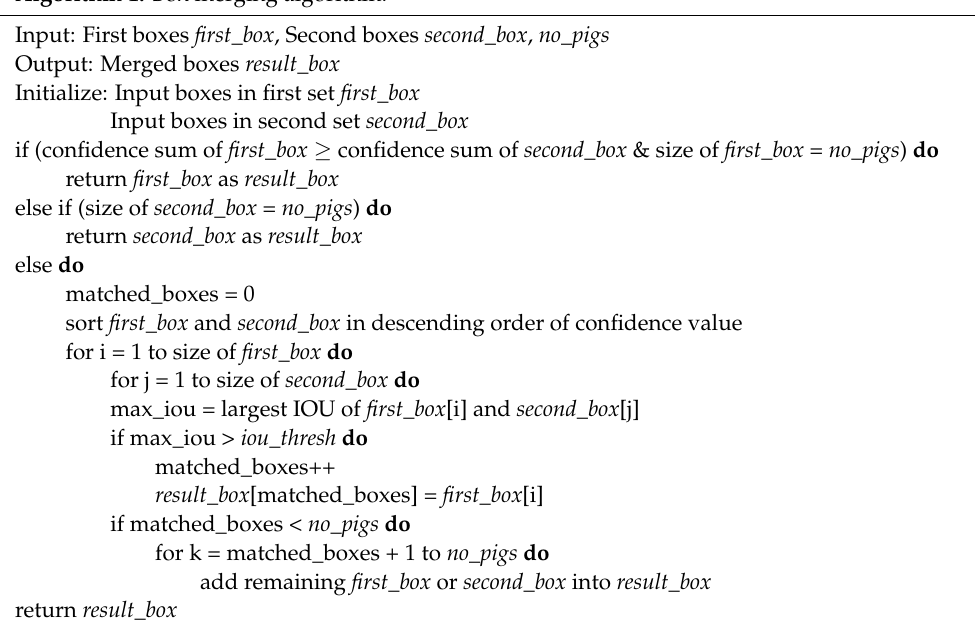
Algorithm 1. Box merging